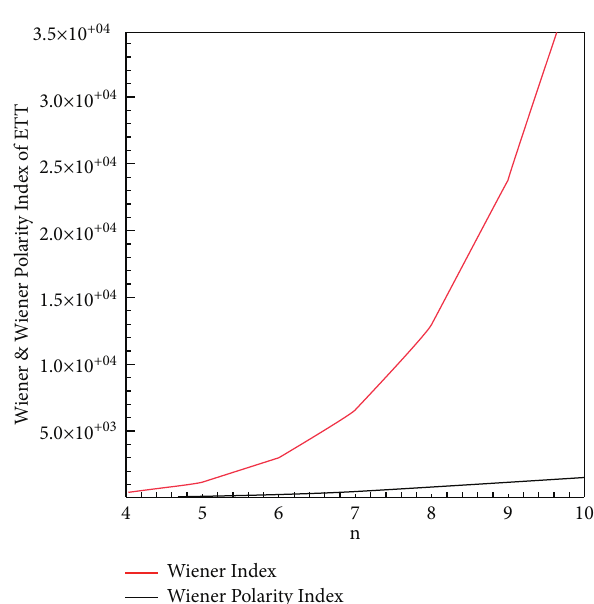
Figure 4: Comparison of Wiener and Wiener polarity indices of graph T n .